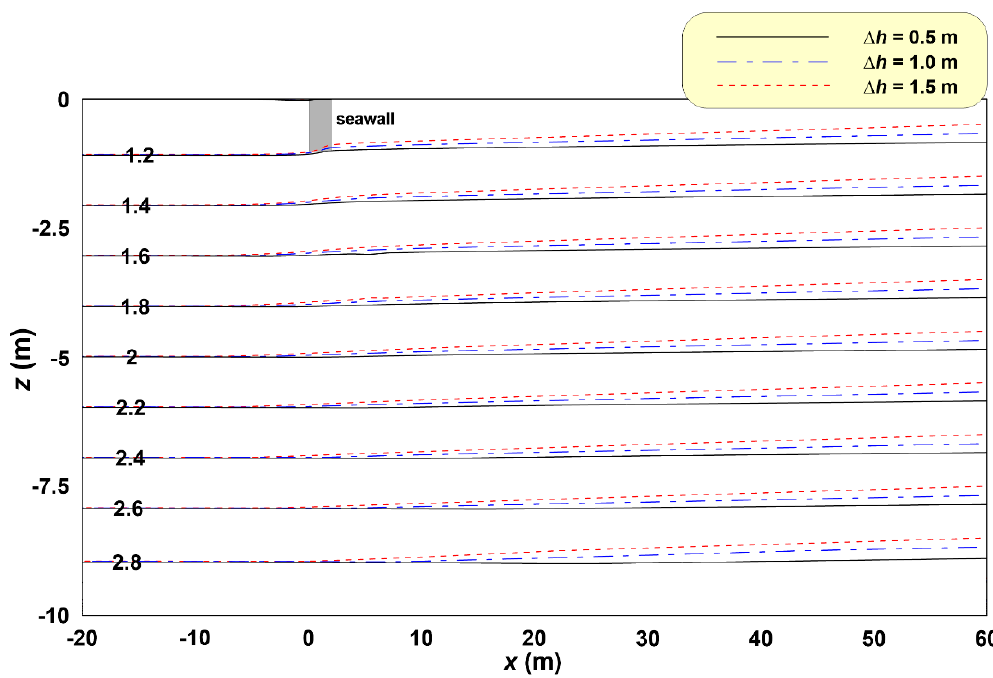
Figure 12. Non-dimensional contour lines of pore water pressure in a coastal aquifer with a seawall.